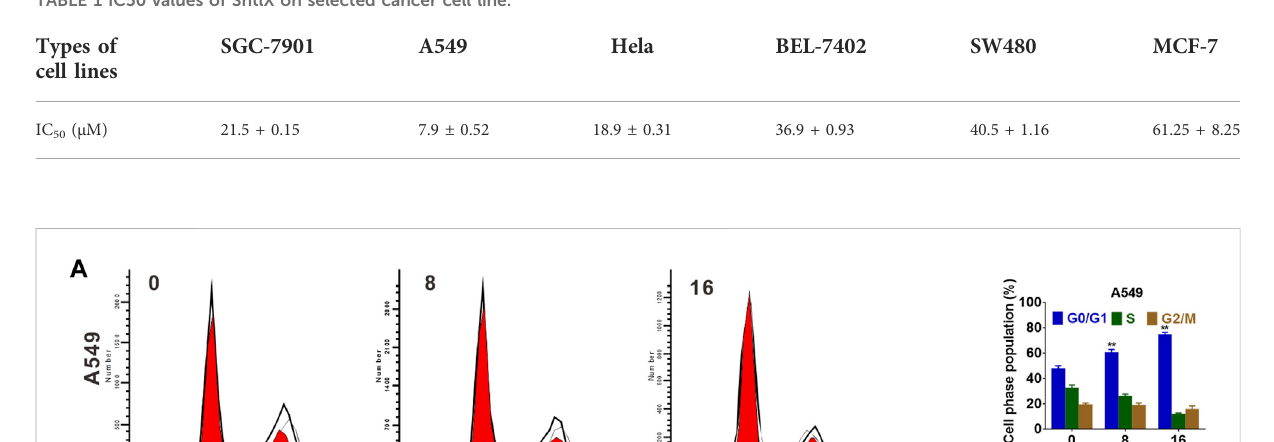
was also active at a dose of 16 μ M in NSCLC cells (Figure 3C). Under the same conditions, Z-VAD-FMK reversed ShtIX (16 μ M)-induced NSCLC cell death, but had no effect on 8 μ M ShtIX (Figures 3D,E). Based on the above